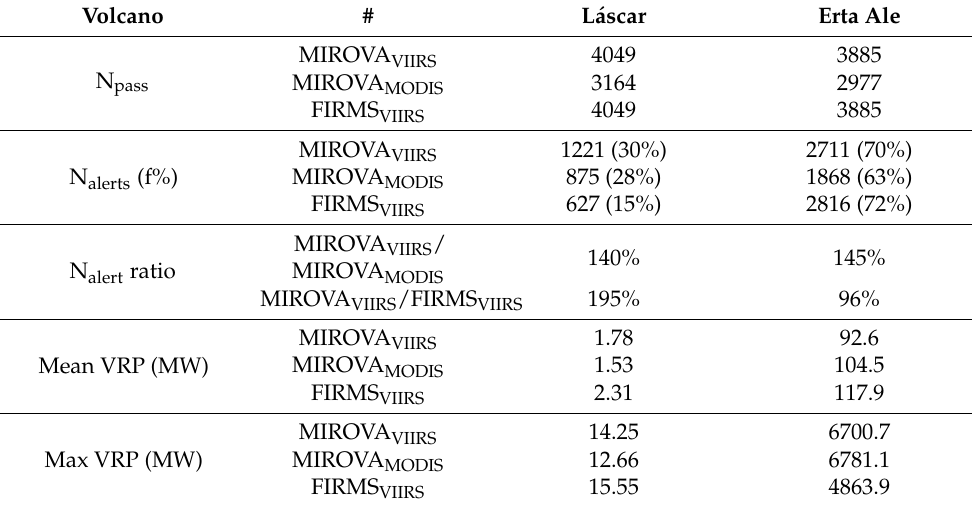
Table 2. Comparison between the datasets MIROVA VIIRS , MIROVA MODIS and FIRMS VIIRS for L á scar and Erta Ale volcanoes. The summary includes the number of overpasses (N pass ), the number of alerts (N alerts ) including the frequency (f%) of alerts (N alert /N pass ), the N alert ratio (ratio between the number of alerts detected by the different algorithms) as well as the mean and maximum VRP/FRP obtained for each dataset. Volcano # L á scar Erta Ale N